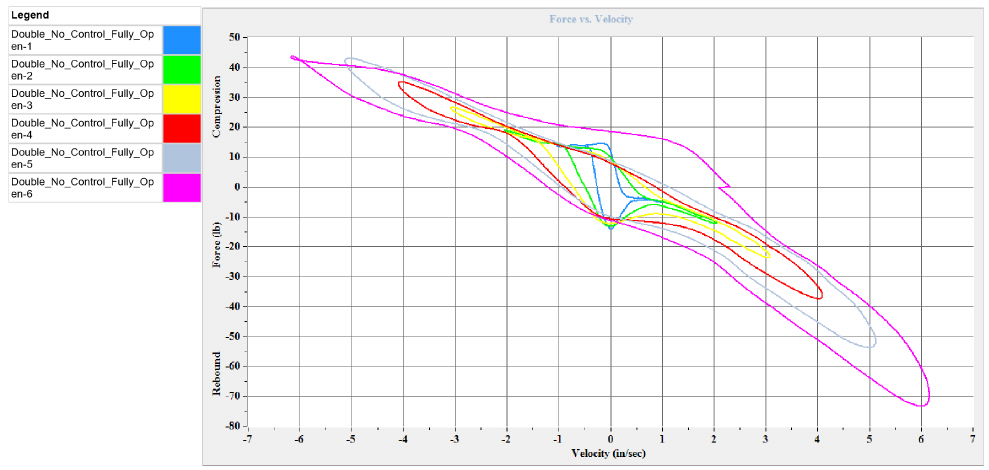
Figure 8. Force vs Displacement Plot for Passive Double Damper with Fully Open Valve (No Control).